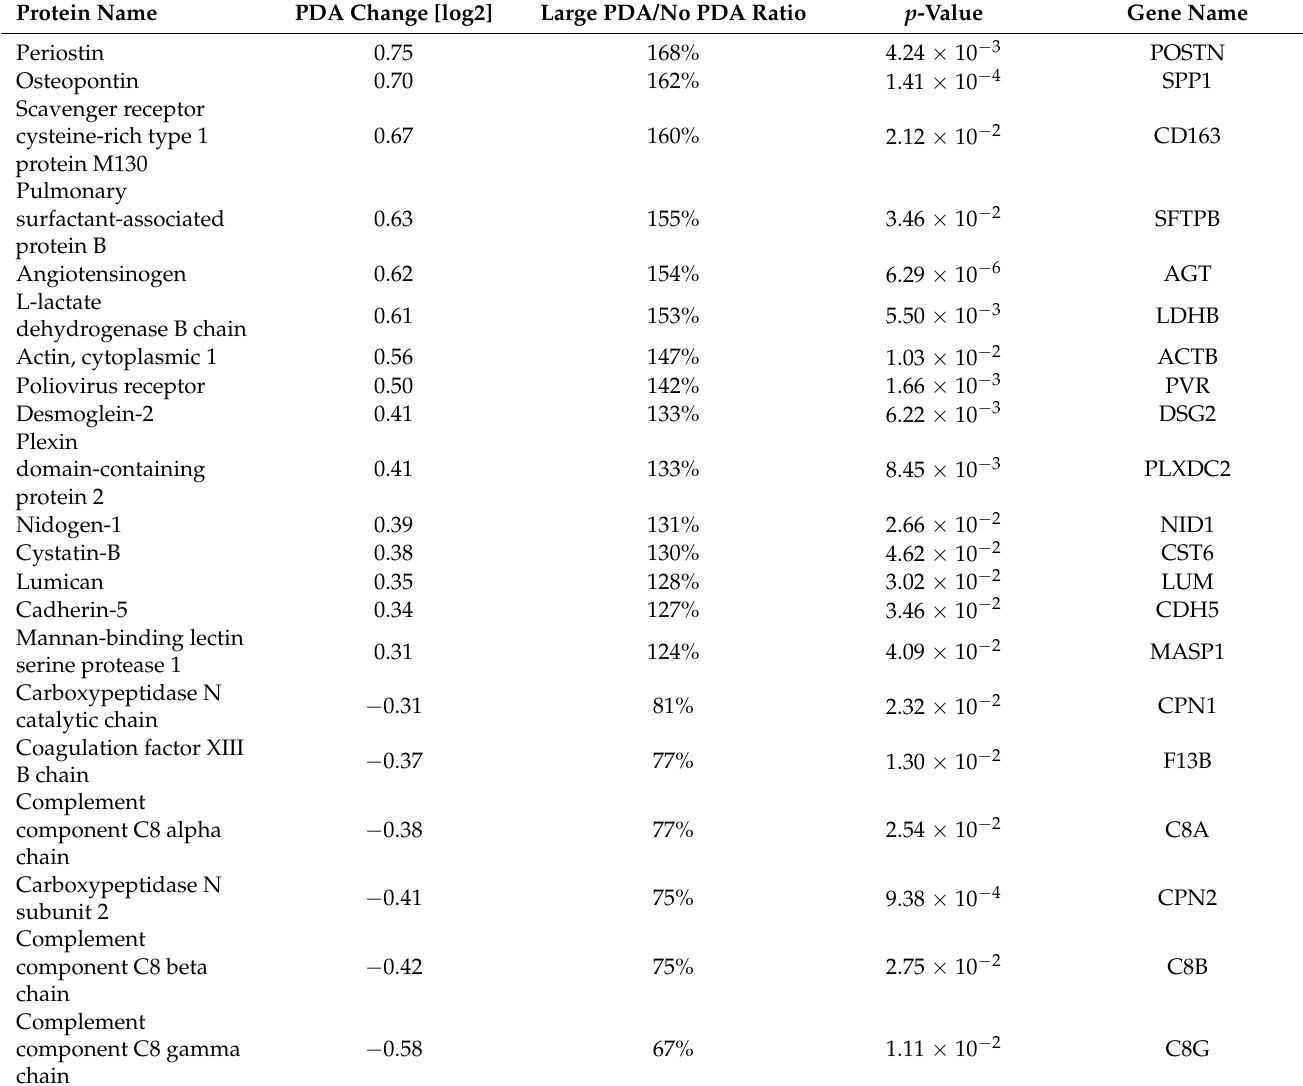
Table 2. Large PDA significant proteins from LC-MS . Statistically significant proteins ( p -value < 0.05) differentiating large PDA from no PDA, as determined by proteomics.